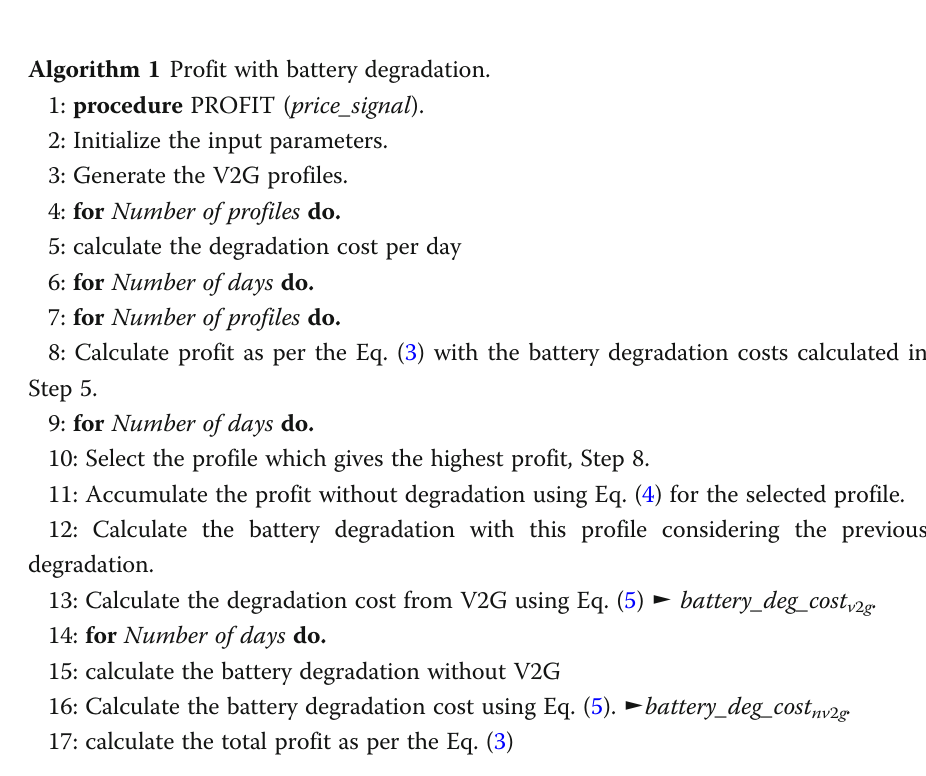
Algorithm 1 Profit with battery degradation.